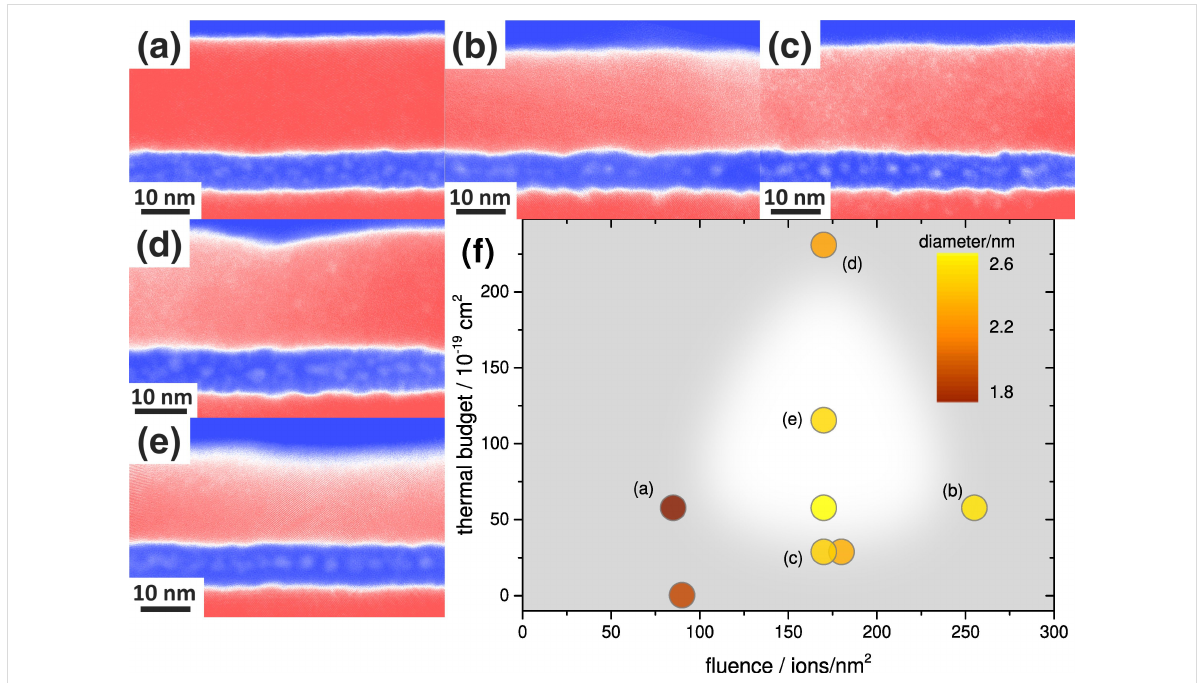
Figure 3: Comparison of different irradiation and thermal treatment conditions. In (a) and (b) low (85 Si + nm − 2 ) and high (255 Si + nm − 2 ) irradiation fluences are compared after applying an identical thermal budget (1323 K, 60 s). In (c) and (d) small (1323 K, 30 s) and large (1323 K, 240 s) thermal budgets are compared after an identical ion beam mixing step has been performed (170 Si + nm − 2 ). In all four cases an energy of 60 keV was used. An overview of several broad-beam irradiated and annealed samples is presented in (f). The plot shows the size of the Si NCs as a function of irradia- tion fluence and thermal budget during the rapid thermal annealing (RTA) process (see text). The color coding of the points in (f) corresponds to the measured Si NC size. The white area in the center is a guide to the eye indicating the parameter space favorable for Si NC formation. Figure (e) cor- responds to the best combination of parameters found (170 Si + nm − 2 , 1323 K, 120